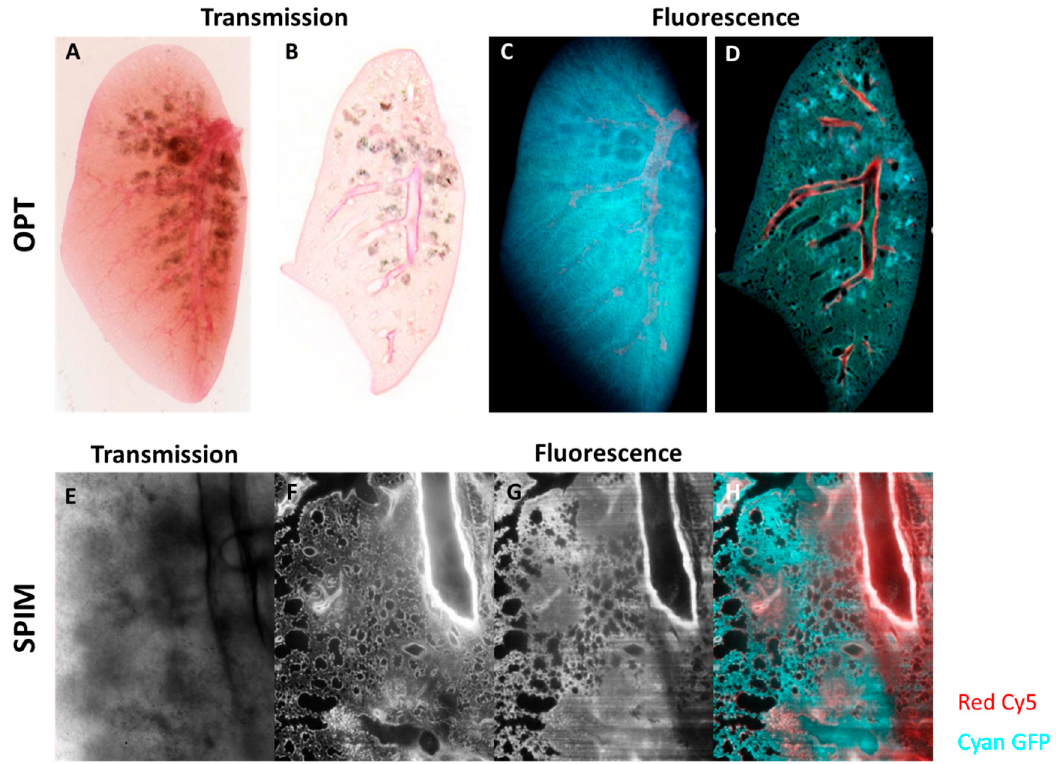
Figure 5. Optical Projection Tomography (OPT) and Selective Plane Illumination Microscopy (SPIM) of silica-induced lung fibrosis. Mice were oropharyngeally instilled with crystalline silica particles (5 mg / mice), sacrificed and imaged 35 days after instillation. OPT transmission imaging of optically cleared lungs shown as a “raw” projection ( A ) and as a reconstructed slice ( B ). The regions with concentrations of silica particles can be seen as grey blotches in the transmission images ( A , B ). OPT fluorescent images of projected ( C ) and reconstructed ( D ) lungs. In fluorescence, the larger vascular structures can be seen in the Cy5 channel (red in images C , D ), and the general structure is visualized using autofluorescence in the GFP channel (cyan in C , D ). A more in-depth and spatial analysis of optically cleared lungs using SPIM shows a transmission image ( E ) and corresponding fluorescence optical slices in the Cy5 ( F ) and GFP ( G ) channels. ( E ) is a transmission image taken in the SPIM showing a field of view with regions containing silica particles (note that this is a traditional wide-field image, not an optical section). Optical sections of fluorescence are shown in ( F – H ), where regions with both normal structure and fibrosis can be seen. The images in ( F , G ) are shown in color overlay in ( H ). 3D visualizations of the OPT can be found as Supplementary Videos S3a and S3b.